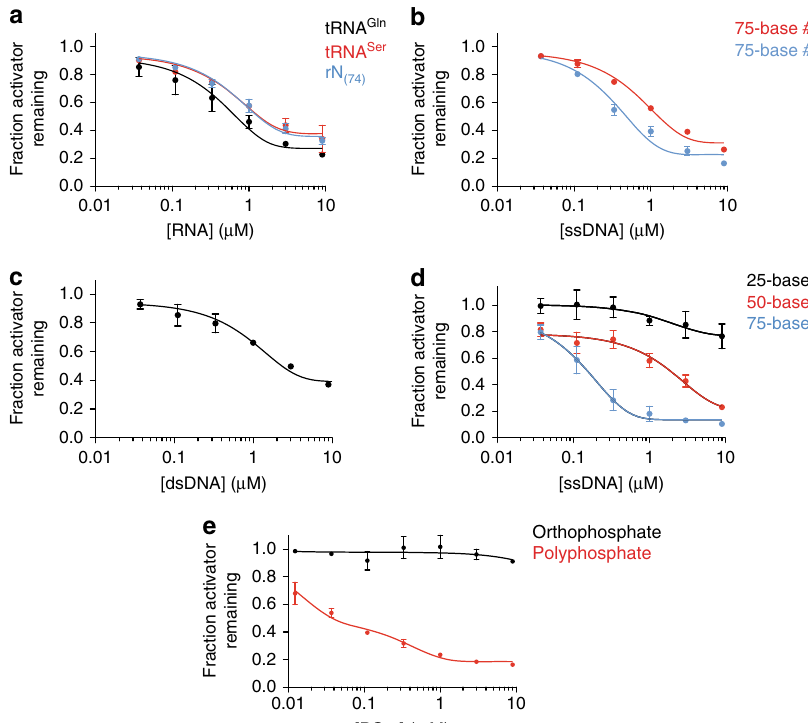
Fig. 3 Nucleic acids and polyphosphate promote activator dissociation. a RNA sequences for glutamine tRNA (tRNA Gln ), serine tRNA (tRNA Ser ), or a degenerate 74-nucleotide long RNA pool (rN (74) ) were transcribed in vitro, puri fi ed, and incubated in Cdh1 dissociation reactions for 45 min. Fraction of Cdh1 remaining at zero RNA concentration was not plotted on the log scale and taken as 1.0. Data indicate means (±SEM) from two independent experiments. Source data are provided in the Source Data fi le. b , c Cdh1 dissociation reactions were performed in the presence of: b two random 75-base ssDNA oligos complementary to each other; or c a double-stranded DNA formed by annealing the two single-stranded DNAs from panel b . See Supplementary Table 1 for sequences. Reactions were supplemented with 2.5 mM MgCl 2 and 3 mM ATP. Data indicate means (±SEM) from two independent experiments. Source data are provided in the Source Data fi le. d Single-stranded DNA oligonucleotides of varying lengths were tested for Cdh1 dissociation in the presence of 2.5 mM MgCl 2 and 3 mM ATP. The 75-base ssDNA used here and in all subsequent experiments is the 75-base ssDNA #2 in panel b . Data indicate means (±SEM) from three independent experiments. Source data are provided in the Source Data fi le. e Cdh1 dissociation reactions were performed at the indicated concentrations of orthophosphate (black) or polyphosphate (red) in a reaction buffer containing 3 mM ATP and no magnesium. Data indicate means (±SEM) from three independent experiments. Source data are provided in the Source Data fi le. NATURE COMMUNICATIONS| (2019) 10:5807